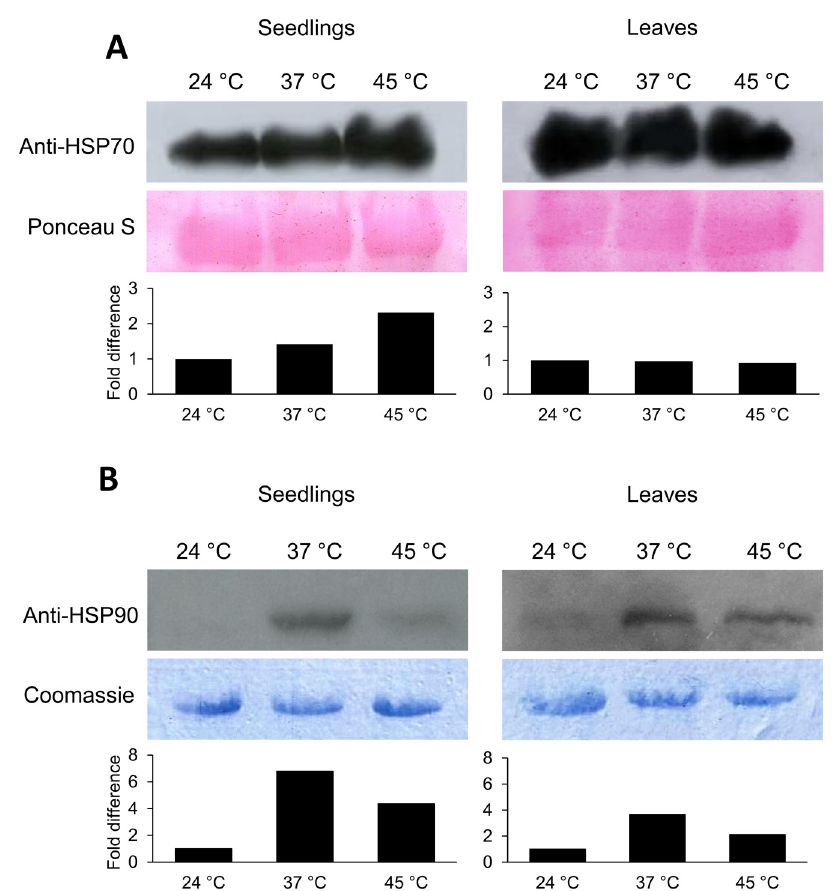
Figure 7. Heat stress effects on HSP70 and HSP90 protein accumulation in tomato seedlings and adult plant leaves. Seedlings or adult plants were either treated continuously at 37 °C or at 45 °C followed by recovery. Control plants were kept at 24 °C (Figure S1C,D). Proteins were isolated from seedlings or young leaves harvested 24 h after the beginning of the treatment. Each biological replicate consisted of 15 seedlings or leaves pooled from 6 adult plants. Immunoassay signals of HSP70 ( A ) and HSP90 ( B ) were normalized to the total protein intensities on nitrocellulose membrane after staining with Ponceau S or PVDF membrane after staining with Coomassie Brilliant Blue.